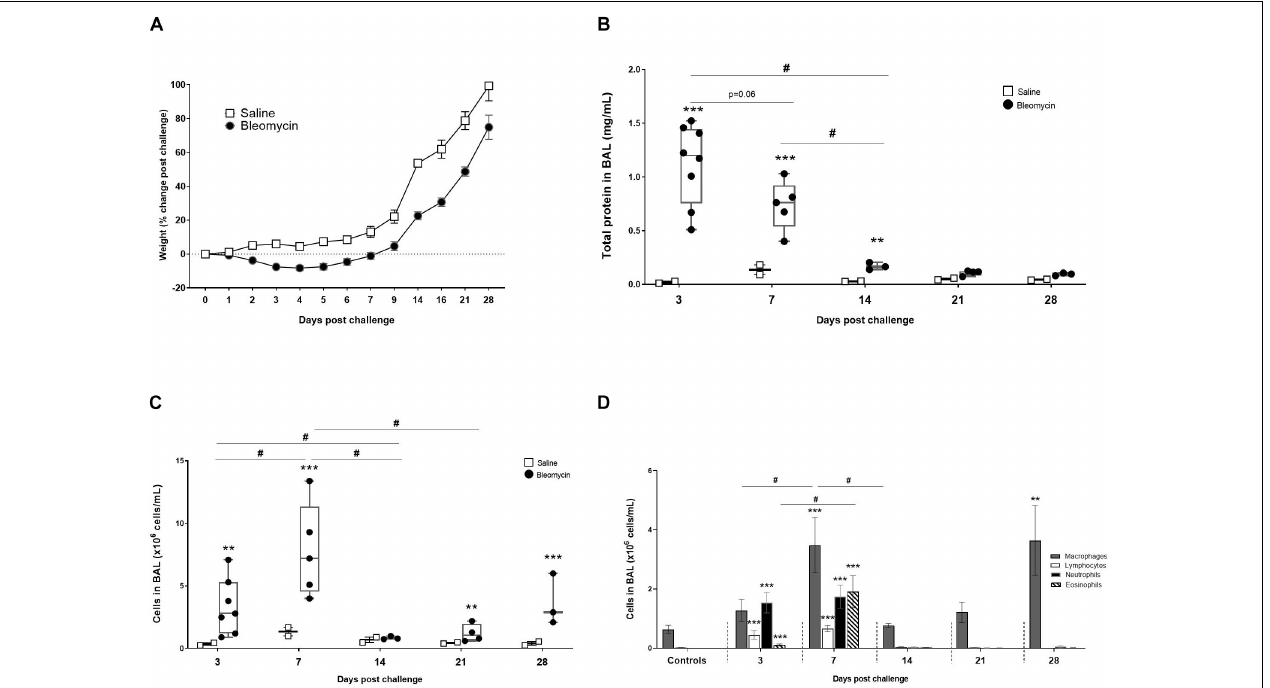
FIGURE 2 | Characterization of the DIILD model, with bleomycin-induced lung injury. (A) Total body weight change in rats over time, expressed as% change compared to their baseline weight. From the BALF analysis total protein concentration and immune cell were assessed at different time points. (B) The total protein reflected plasma exudation and edema at initial inflammatory phase of the bleomycin model (day 3–7 post challenge). (C) The total cell count from BALF was peaking at day 7. Significant increase of cells was also observed at the latest time point (day 28), indicating a second phase of immune cell infiltration. (D) Differential cell counts indicating which cells dominate the various time points. The cells induced at the latest time point (day 28) are only macrophages although present at levels similar to the acute inflammation time point (day 7). Significance is indicated by ** when p < 0.01 and *** when p < 0.001. The comparison of various time points between bleomycin-challenged groups is expressed as # when p <